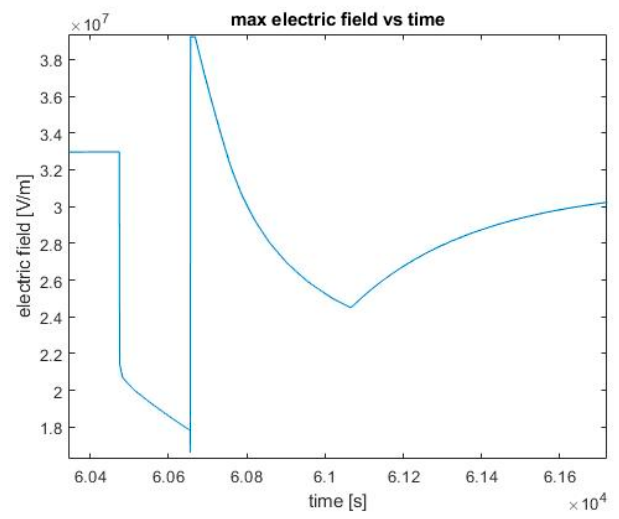
Figure 9. Maximum absolute value of electric field in the modeled cable portion—Scenario D, detail.